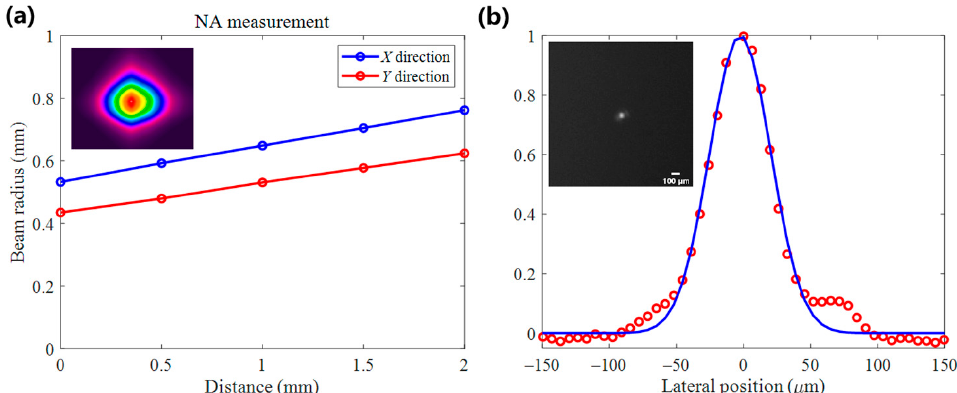
Figure 6. ( a ) Lensed fiber far-field NA measurement. The inset figure in the upper left is the Gaussian beam spot measured at the lensed fiber output. ( b ) Lensed-fiber near-field spot measurement. Red circle: measured data; Blue line: Gaussian fit. The inset figure in the upper left is the Gaussian beam measured by CMOS camera after the convergence of the lensed fiber. The scale bar is 100 µ m.